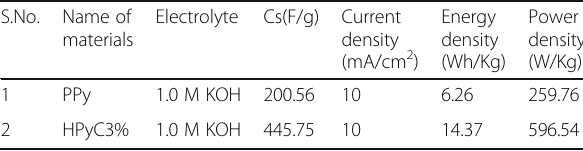
Table 1 Performance comparison of Hb-based PPy supercapacitors. The table shows the comparison of electrochemical performance of reported PPy and HPyCs in this work